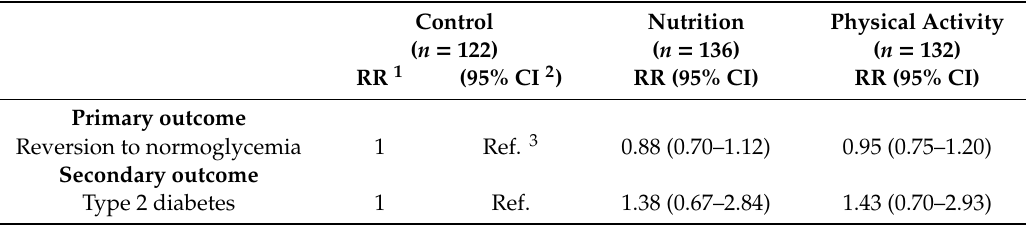
1 Standard deviation. Table 3. Primary and secondary study outcomes.